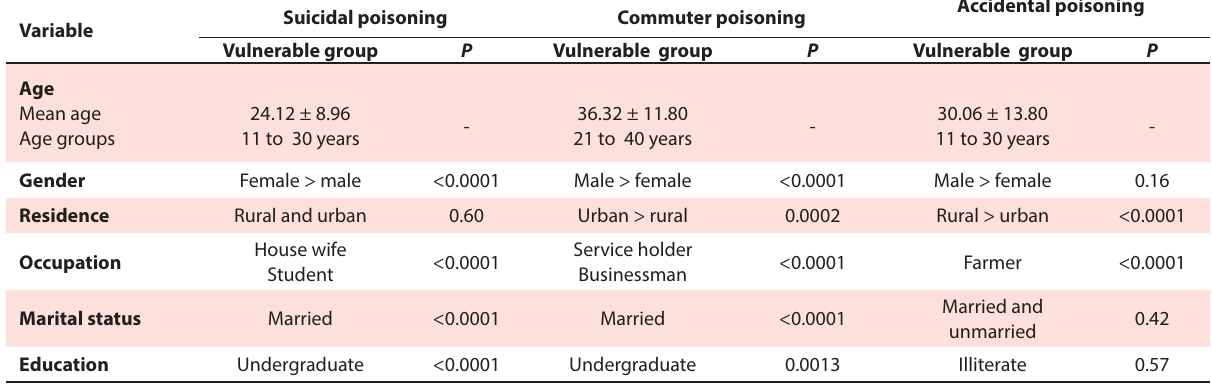
Table 3. Characteristics of vulnerable groups according to mode of poisoning Suicidal Variable